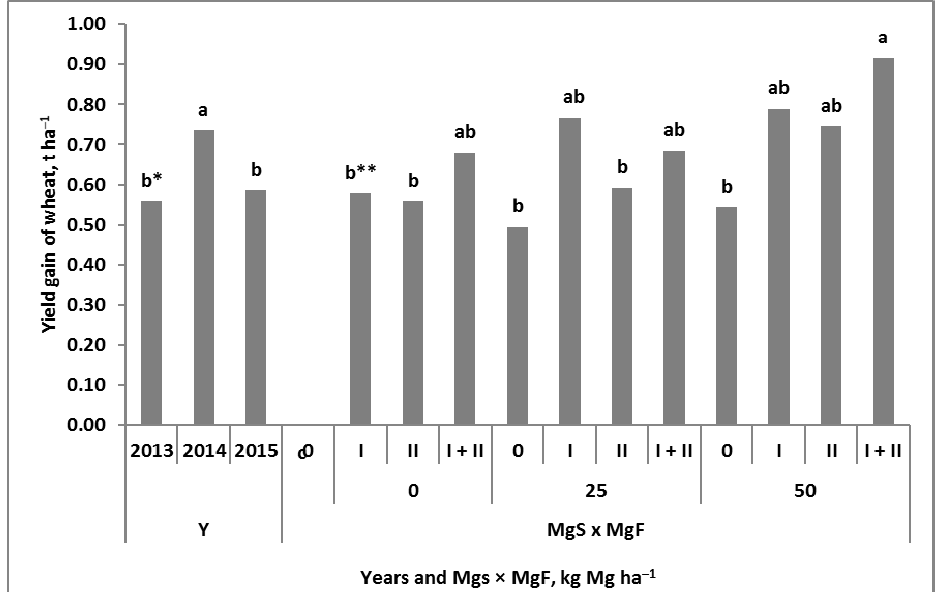
Figure 1. The net increase in the yield of winter wheat in response to the interaction between Mg fertilization systems. Mgs and Mgf — soil and foliar Mg fertilization systems, respectively. * Doses fertilization systems. a, b. Similar letters mean a lack of significant differences using Tukey’s test. of applied Mg, kg ha ‒1 ; ** stages of Mg. Wheat stages of Mg foliar fertilization: I — BBCH 30; II — Mgs and Mgf—soil and foliar Mg fertilization systems, respectively. * Doses of applied Mg, kg ha − 1 ; BBCH 49/50. ** stages of Mg. Wheat stages of Mg foliar fertilization: I—BBCH 30; II—BBCH